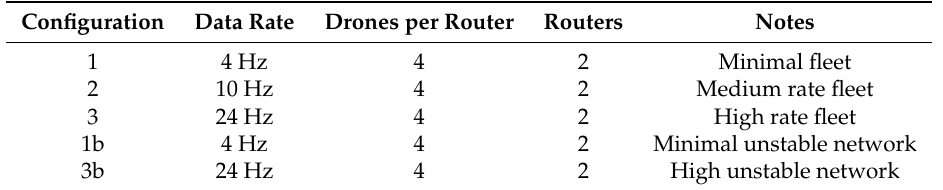
Table 3. Test configurations.